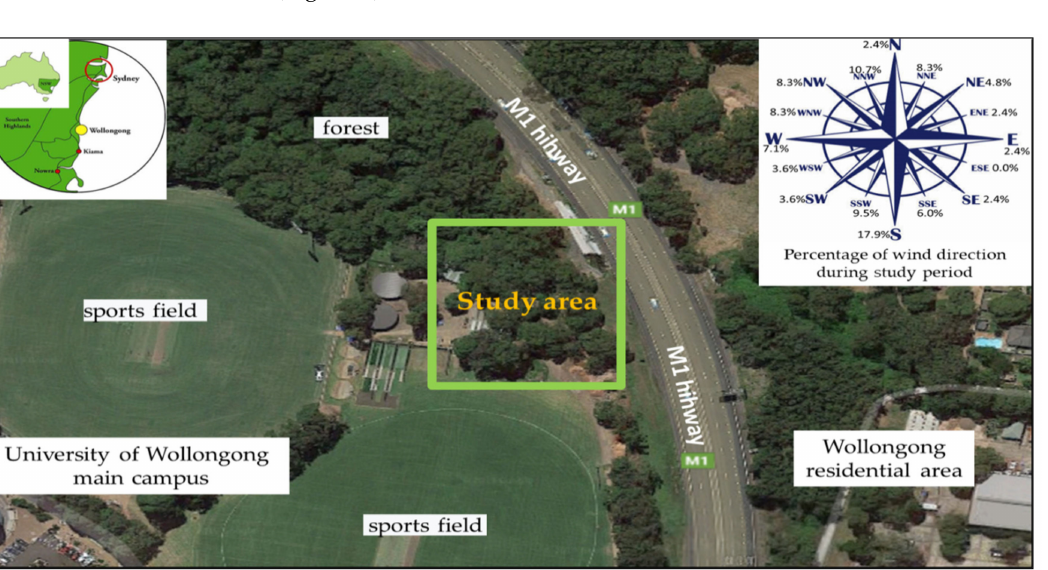
Figure 1. Map showing location of the study area with a wind rose showing percentage of wind direction during the study period. Satellite image from Google Maps; Google